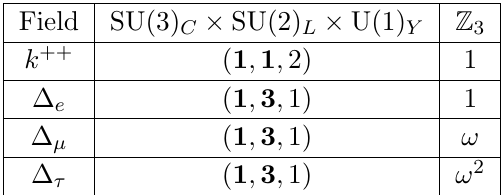
Table 3 . Quantum numbers of the additional scalar (cid:12)elds in Scenario B under the SM gauge group and Z 3